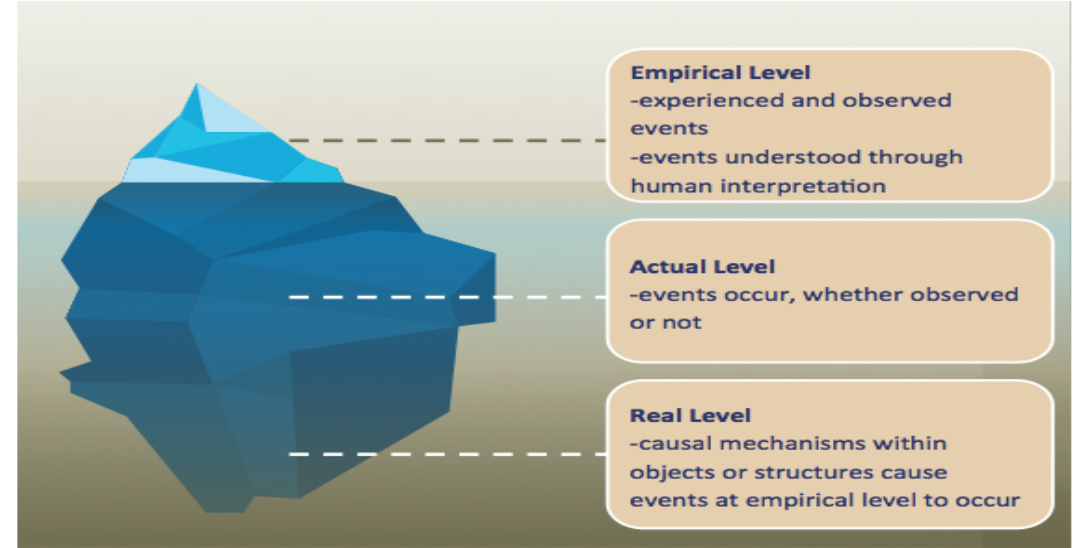
Figure 1 : Iceberg metaphor of layered ontology adopted from Fletcher